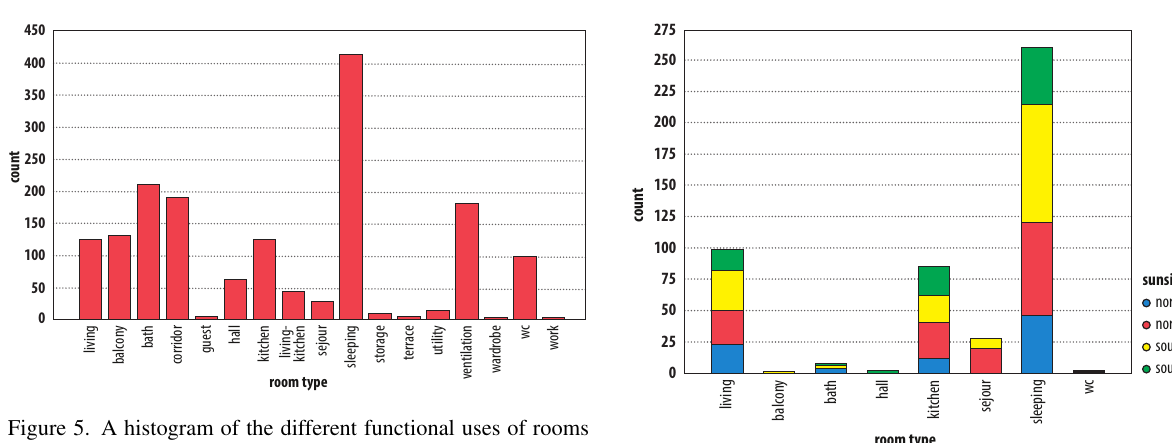
Figure 4. Excerpt from the spatial relational database schema. Features are extracted from this data base.